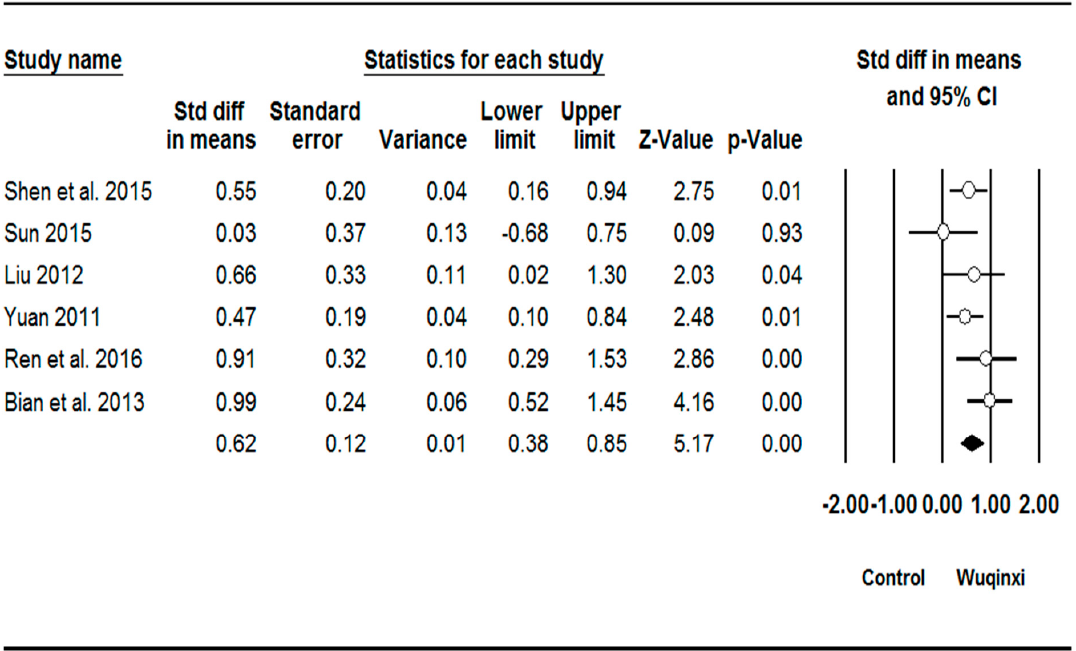
Figure 2. Effect of Wuqinxi on systolic blood pressure. Effect size (95% CI) of each study is denoted by circle (black line). The mid-point of the circle represents the point effect estimate, meaning effect estimate for each study. The area of the circle represents the weight given to the study. The diamond below the studies represents the overall effect.